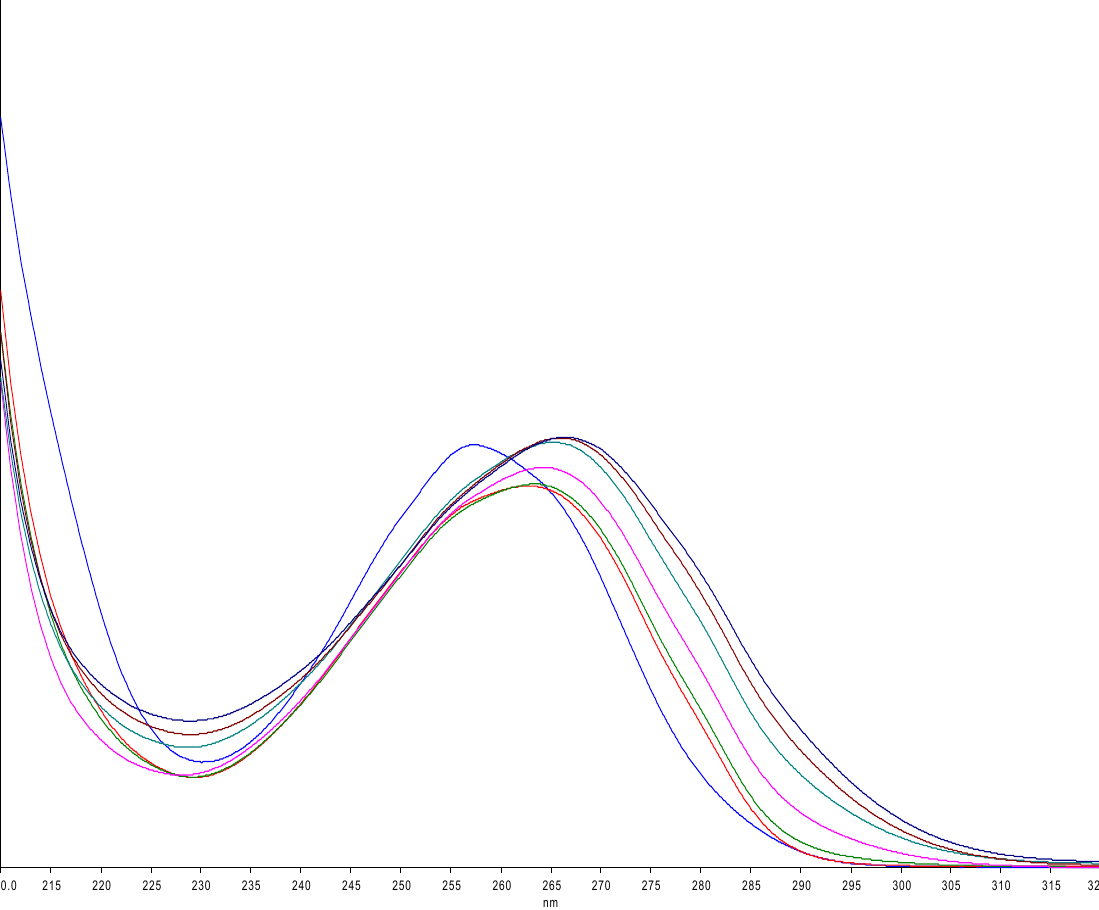
at [HCl] 1M at 60°C. 2